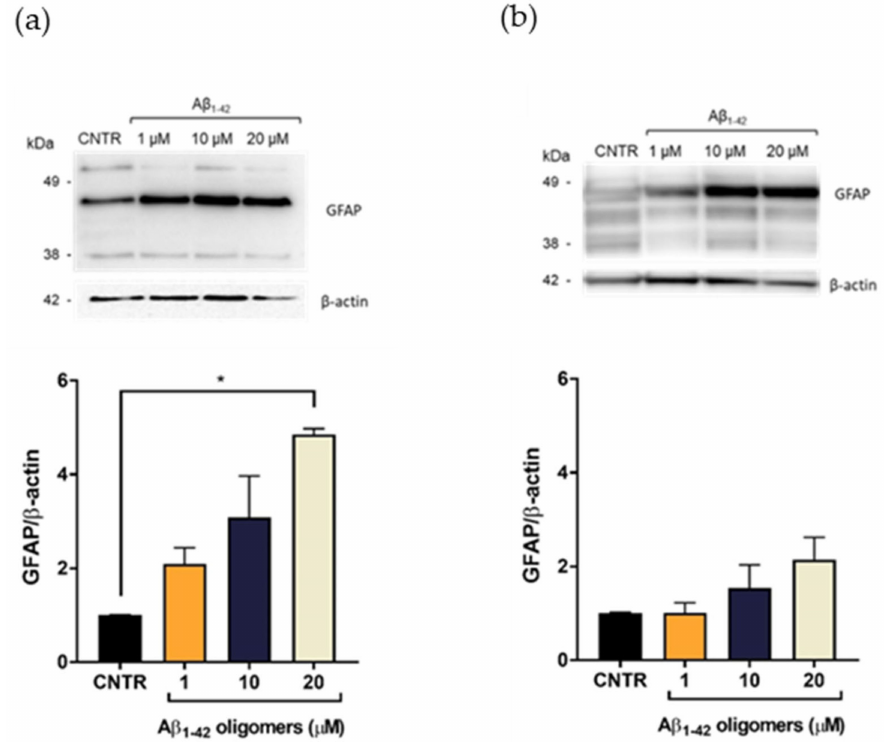
Figure 3. Quantification of GFAP expression levels in NHA after exposure to A β 1-42 oligomers via SDS-PAGE/WB. NHA cells were treated with a preparation of A β 1-42 , enriched in oligomers, at increasing concentrations (1 µ M, 10 µ M, and 20 µ M) for 24 ( a ) and 48 ( b ) h. The data are expressed as the mean of the samples in triplicate ± SEM; * p <0.05 (one-way ANOVA). On the contrary, the presence of A β 1-42 fibrils caused a reduction of GFAP expression levels. GFAP levels were halved after incubation with A β 1-42 concentration ≥ 10 µ M after 24 h of incubation (Figure 4a). After 48 h of A β 1-42 treatment, the reduction of GFAP was dose dependent and GFAP levels were halved with 20 µ M A β 1-42 (Figure